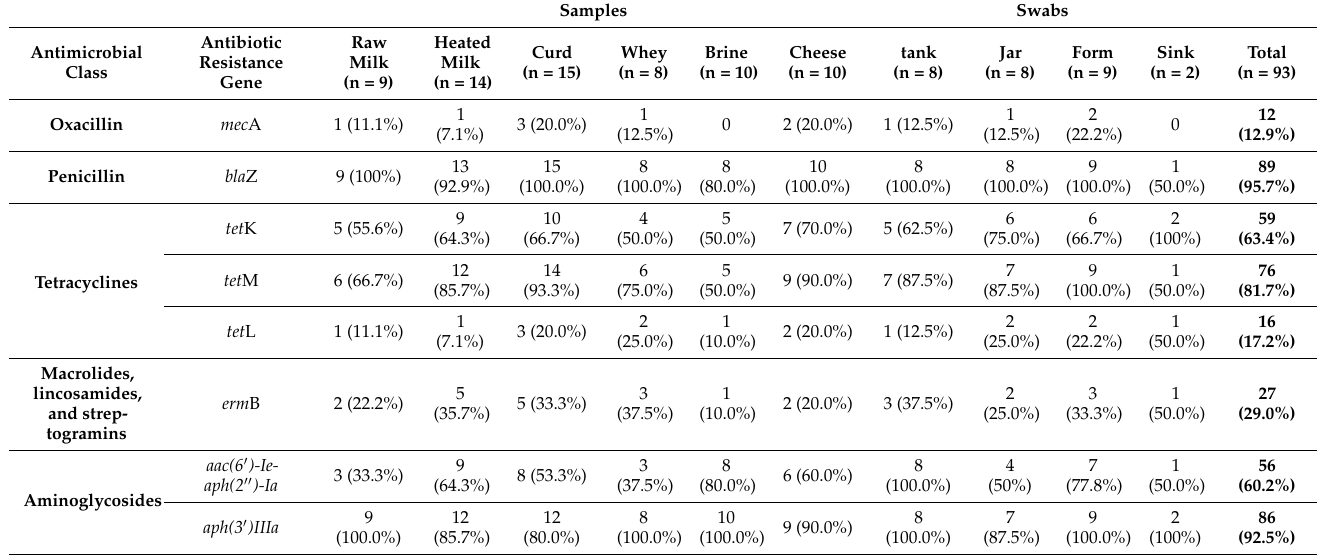
Table 3. Occurrence of antimicrobial resistance genes against tested antimicrobial agents in S. aureus . Samples